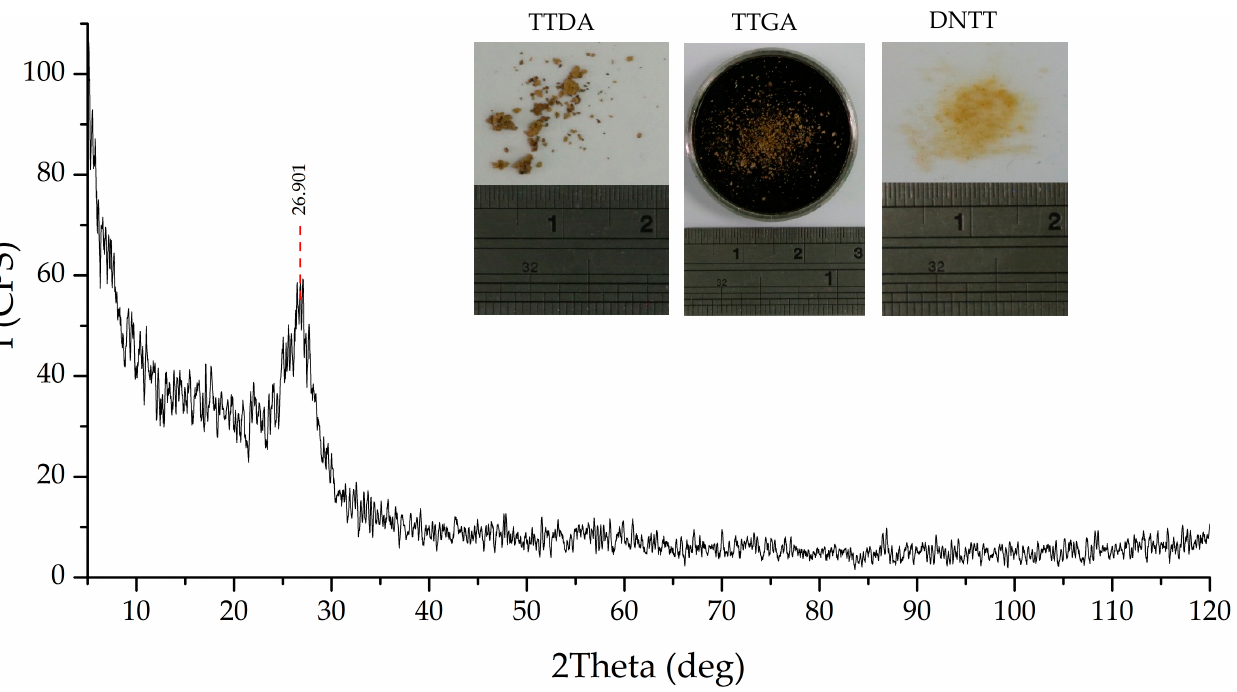
Figure 11. X ‐ ray diffraction data of a powdered sample of the α‐ phase of carbon nitride. Table 7. Crystal structure of the obtained α‐ phase of carbon nitride.